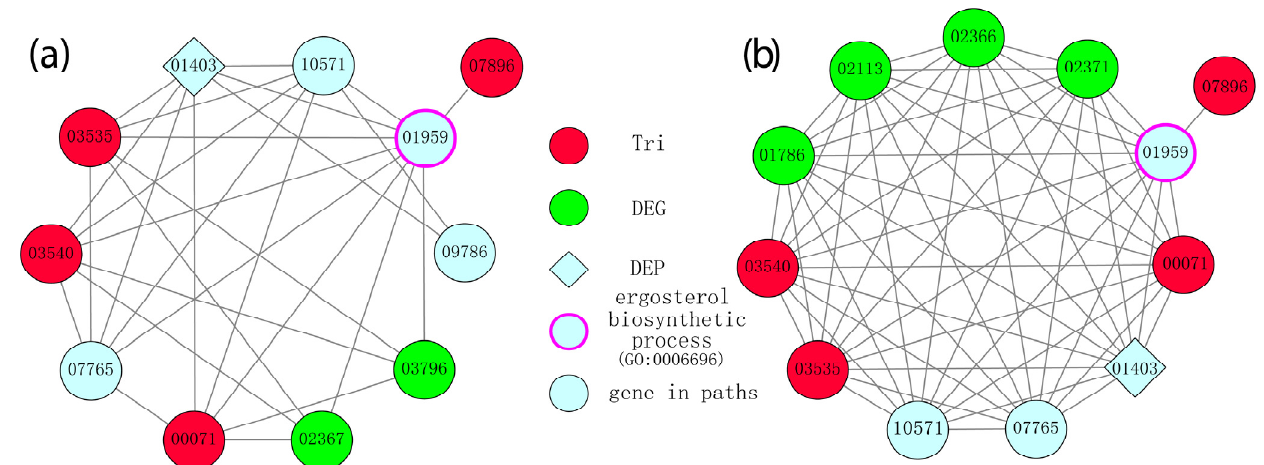
Figure 6. Gene clusters were identified in the sub-network consisting of the shortest paths connecting DEGs and TRI -family genes for ( a ) different-chemotype and ( b ) different-productivity groups. Nodes represent genes contained in the shortest paths, while edges represent the PPIs made up of paths. The TRI -family genes are marked as red, while the differentially expressed protein FGSG_01403 identified in proteome analysis and differentially expressed genes (DEGs) are marked as rhombi and green, respectively.